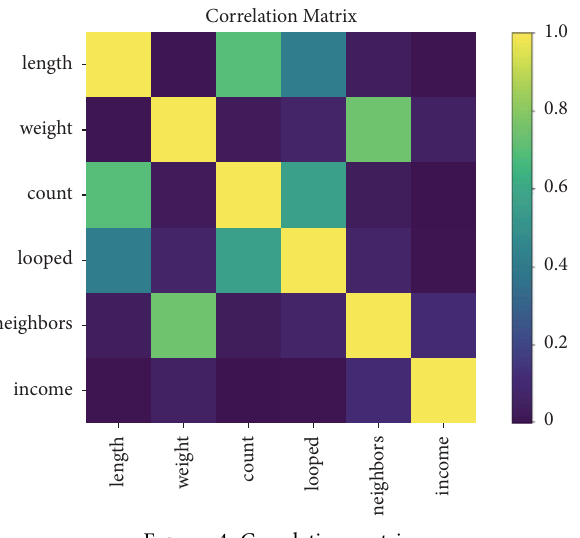
Figure 4: Correlation